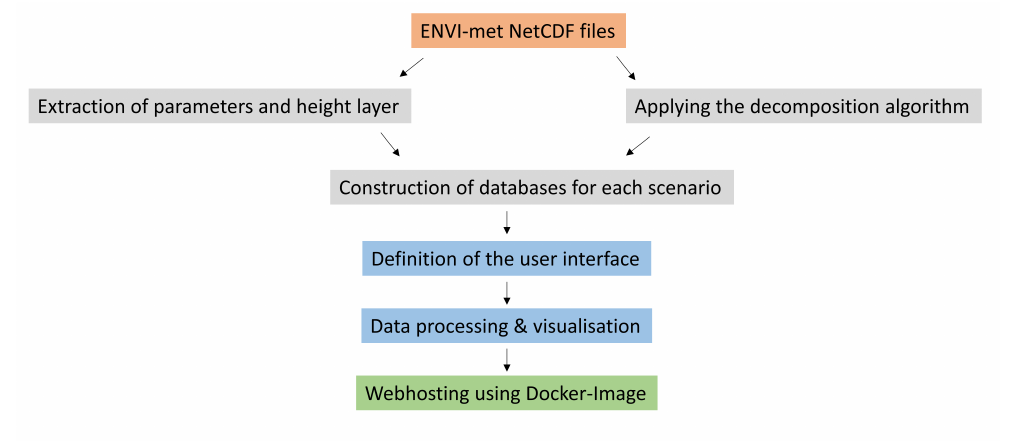
Figure 3. Data flow for the online visualisation